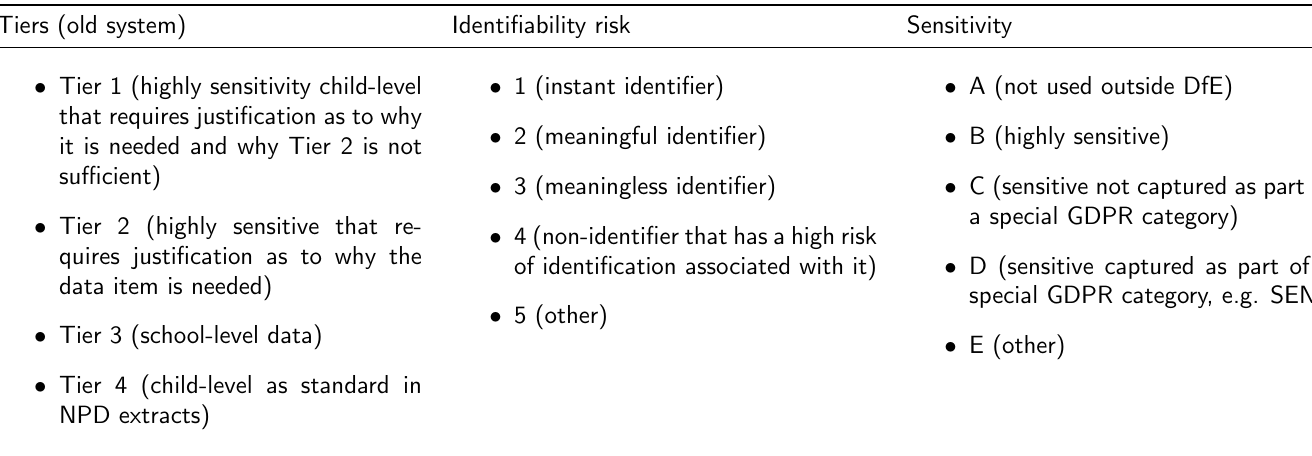
Table 1: Validation of child health